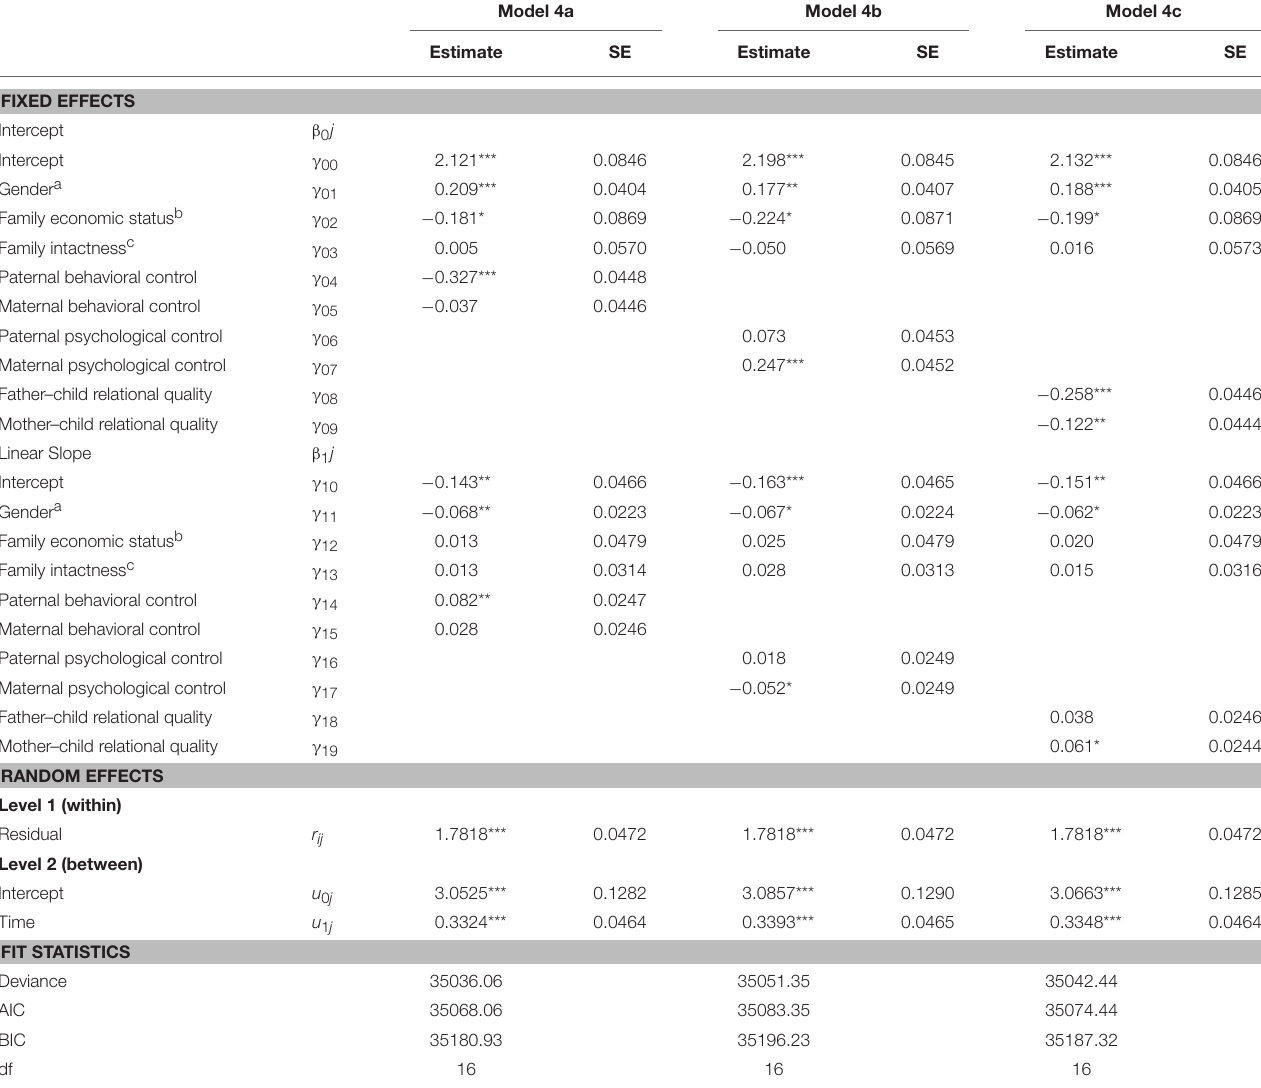
TABLE 6 | Results of IGC models with level-2 predictors for adolescent Internet addiction (Wave 4–6, full